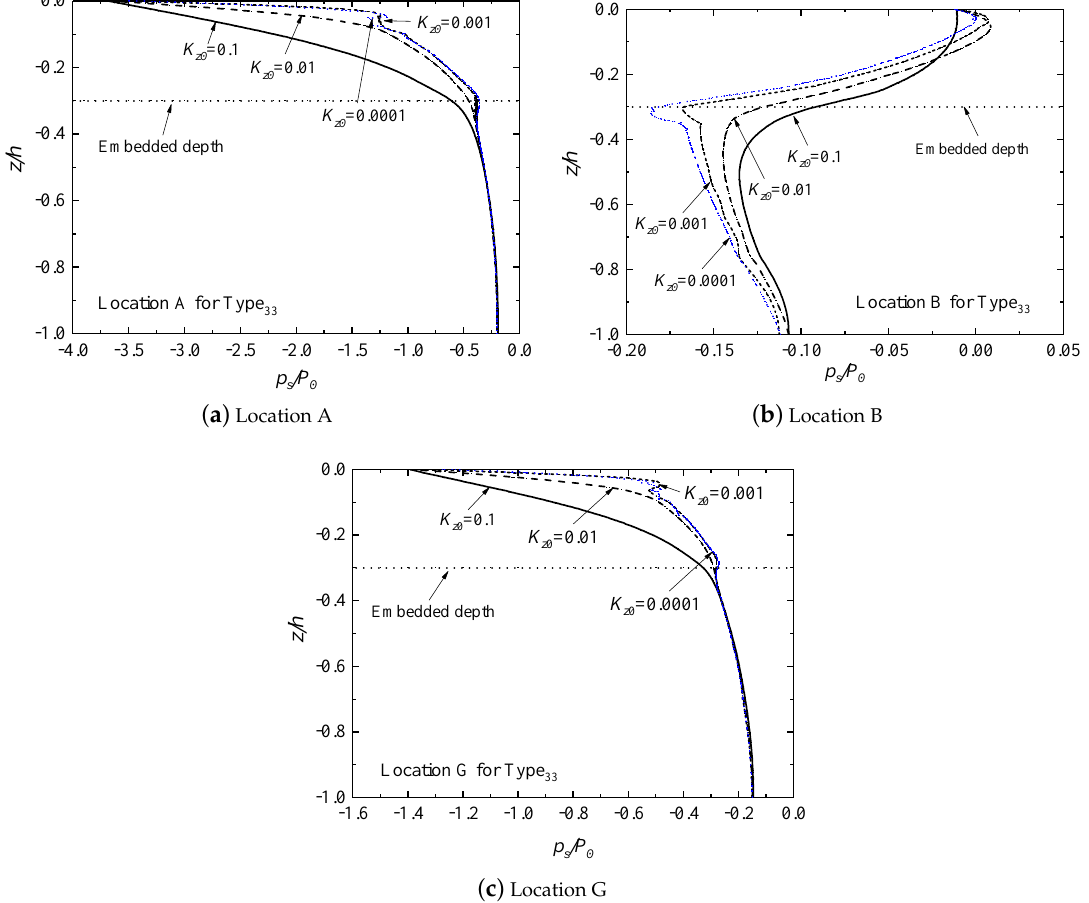
Figure 20. Vertical distributions of pore pressure with various permeability at the seabed surface for Type 33 at t = 83.5